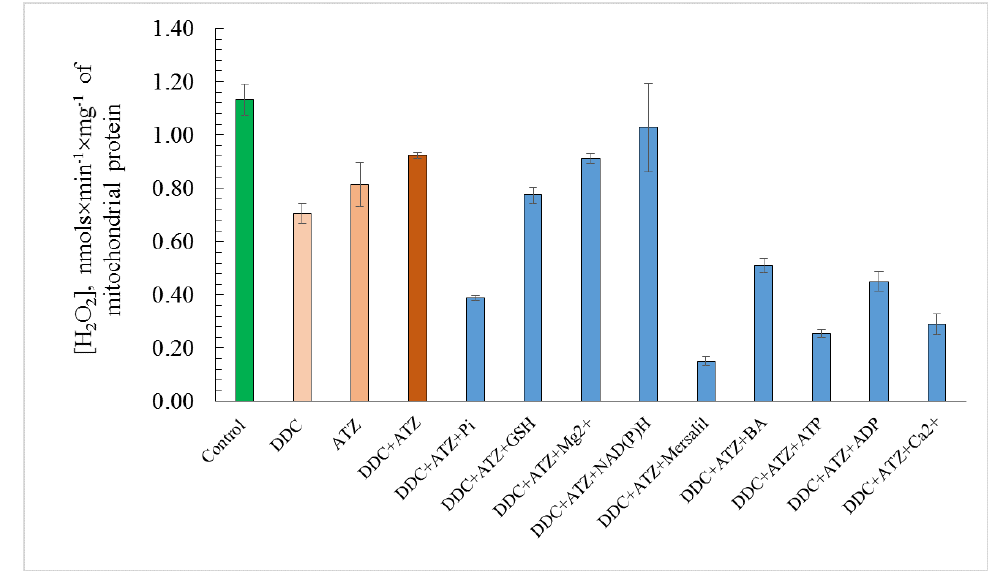
Figure 6. Estimates of total ROS level in E. magnusii mitochondria. The dynamics of intracellular ROS production were monitored using a spectroscopic fluorescence probe of AR. The incubation medium contained 0.4 M mannitol, 0.1 M KCl, 20 mM Tris-acetate, 0.4 mg of mitochondria protein, and pH 7.4. The incubation medium has been amended to indicate 4 mM ATZ, 4 mM DDC, 5 mM Pi, 5 mM GSH, 5 mM Mg , 10 mM NAD(P)H, 100 µ M mersalyl, 5 µ M BA, 150 µ M ATP, 150 µ M ADP, and 500 µ M Ca 2+ . Values are mean ± S.E.M from 5–6 independent experiments. The intensity of ROS production in the version of “positive control” made up 5.89 pmols × min − 1 × mg of protein − 1 . Values with different letters within a column are significantly different at p < 0.05.